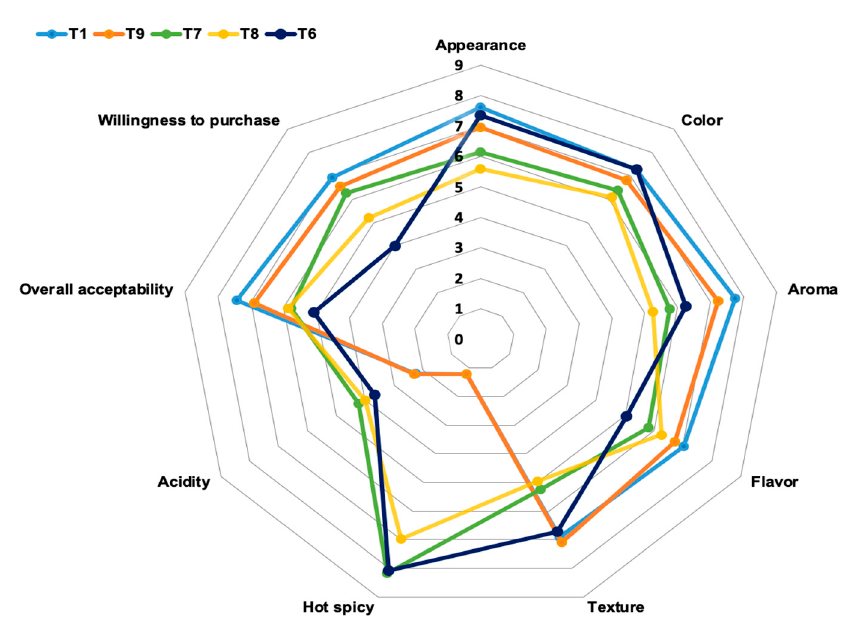
Figure 3. Sensorial results from 40 untrained panelists. Sensorial attributes and purchase intention of beef patties. T1: CM (control), T2: 2% PSW, T3: 4% PSW, T4: 0.35% CA, T5: 2% RS, T6: 2% PSW +